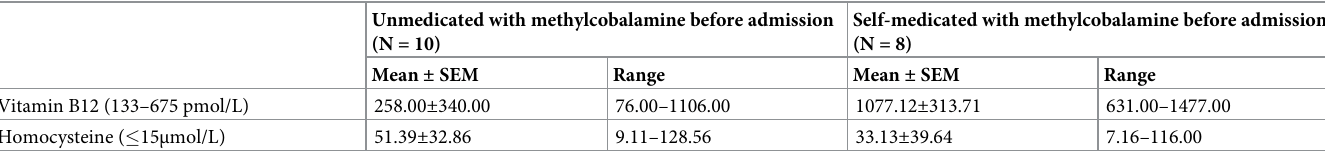
Table 2. Laboratory findings of N 2 O abuse resulting in peripheral neuropathy.